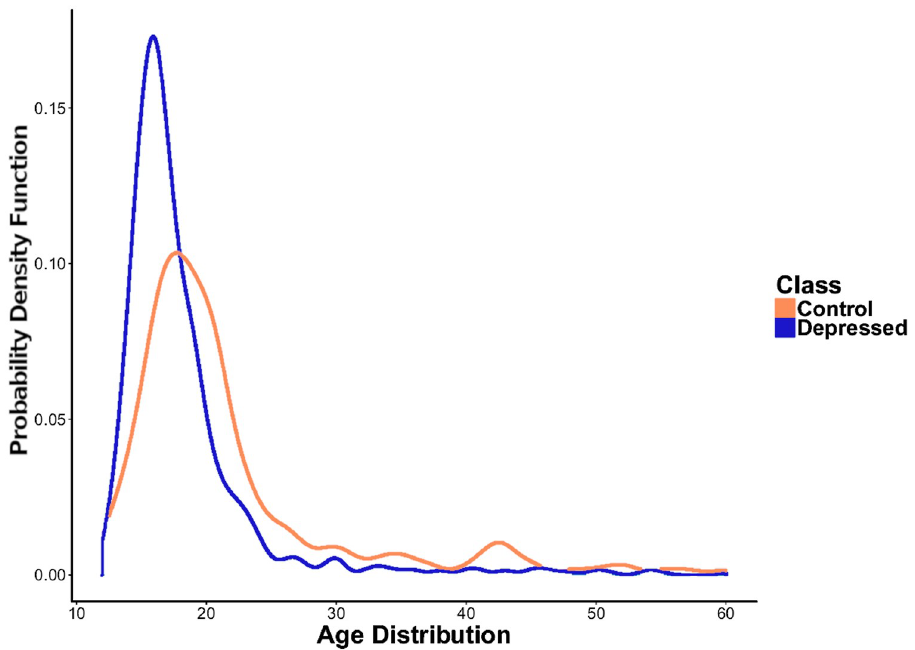
Fig 1. The age distribution for depressed and control users in ground-truth dataset.